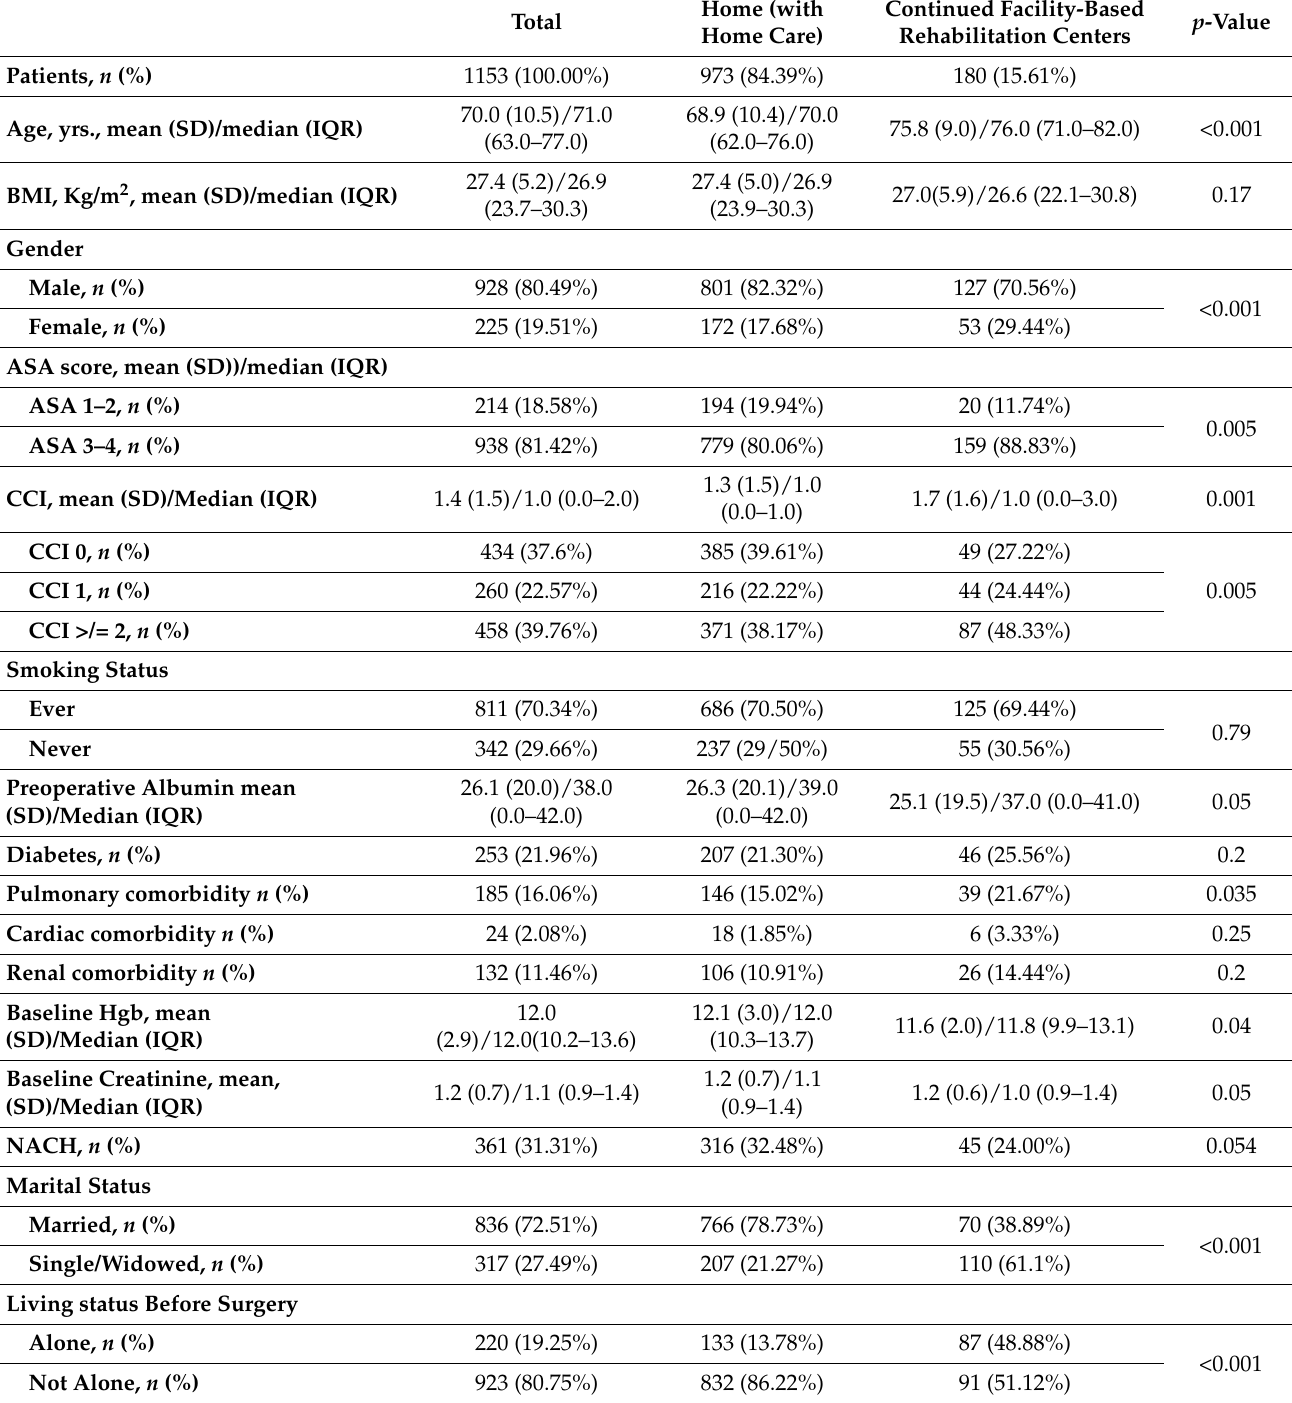
Table 1. Perioperative